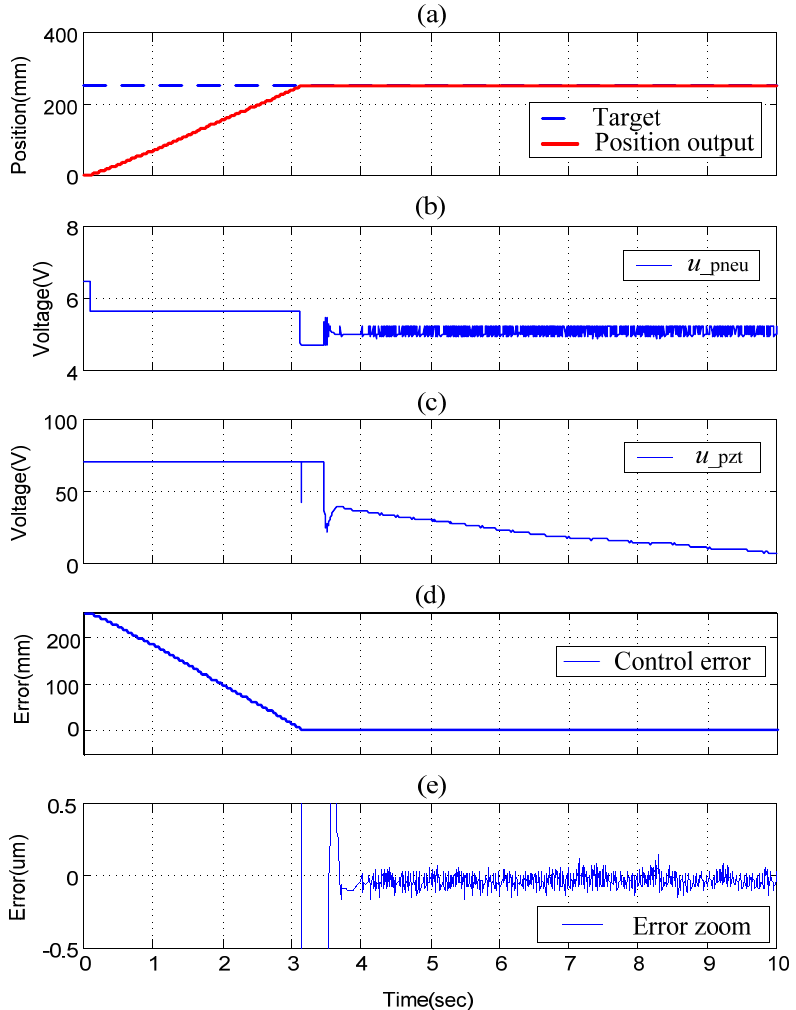
Figure 8. Experimental results of position control of the pneumatic-piezoelectric hybrid actuator for single axis with stroke of 250 mm by SOFSMC (without decoupling compensator): (a) position control response, (b) pneumatic control signal, (c) piezoelectric control signal, (d) position control error, (e) error zoom.